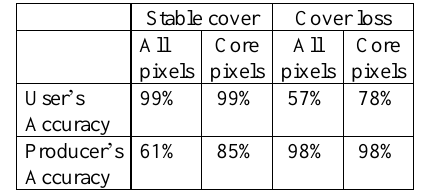
Table 4 . Accuracies of best model with three post-change images integrated as model input data.